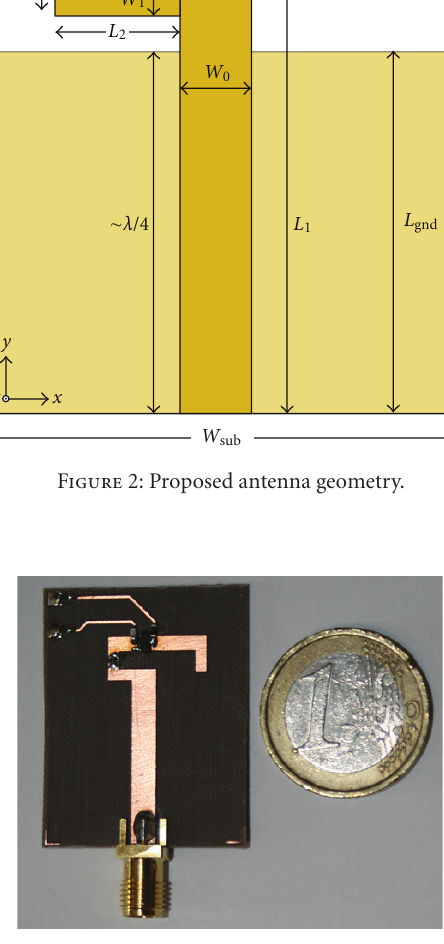
the PIN diode, the resonant frequency in both antenna configurations turns to be smaller, resulting in a reduced volume occupation.